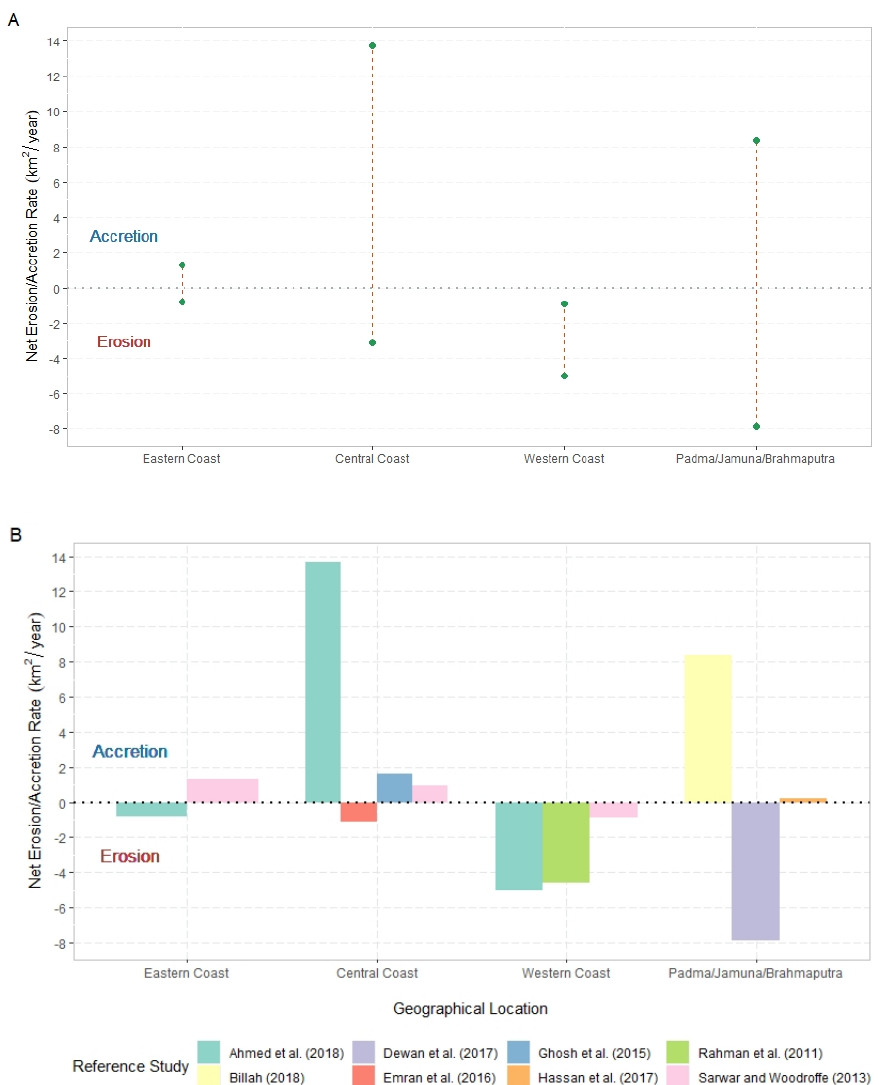
Figure 9. Net erosion and accretion rate (in square kilometer) per year. ( A ) represents the location-wise range of erosion/accretion rate. ( B ) demonstrates study and location-wise specific erosion/accretion rate [54–56,58,59,61,62,64]. In Bangladesh, landslides occur mainly in the hilly south-eastern region known as the Chittagong Hilly Areas (CHA). We found that out of seven studies only one study produced landslide inventory for the entire CHA [72]. Other studies focused on creating LSMs for the two largest urban parts of the CHA-Chittagong Metropolitan Area (CMA) [73,74] and Cox’s Bazar municipality [75], as well as for landslide prone Rangamati district [76]. Landsat TM and OLI images and MLC approach were used for mapping land use land cover change and developing indices (i.e., NDVI) [73,77], while Advanced Spaceborn Thermal Emission and Reflection Radiometer (ASTER) Global Digital Elevation Model (GDEM) (30 m) and ALOS-PALSAR DEM (12.5 m) were used for preparing topographic causal factors such as slope, aspect, profile and plan curvature using the GIS platform [76,78]. In these studies, study areas and methods for creating LSMs were different, so it is difficult to say whether the use of different remote sensing products affected the prediction of the LSMs. Despite experiencing landslides in almost every monsoon, Bangladesh lacks an official inventory of landslides hampering the preparation of LSMs [72]. Furthermore, unavailability of